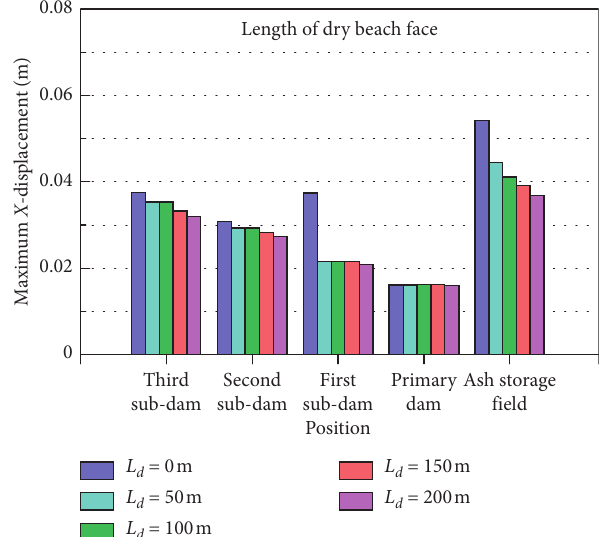
Figure 10: Horizontal displacement of various parts of the ash storage field at different dry beach